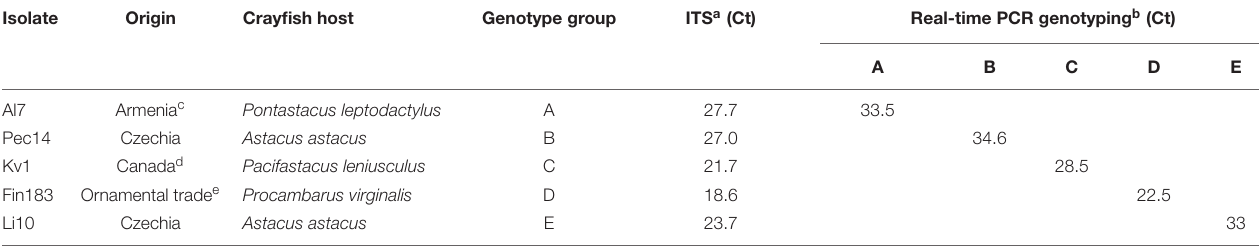
TABLE 2 | Axenic cultures of A. astaci strains used to validate the new real-time PCR assays. Isolate